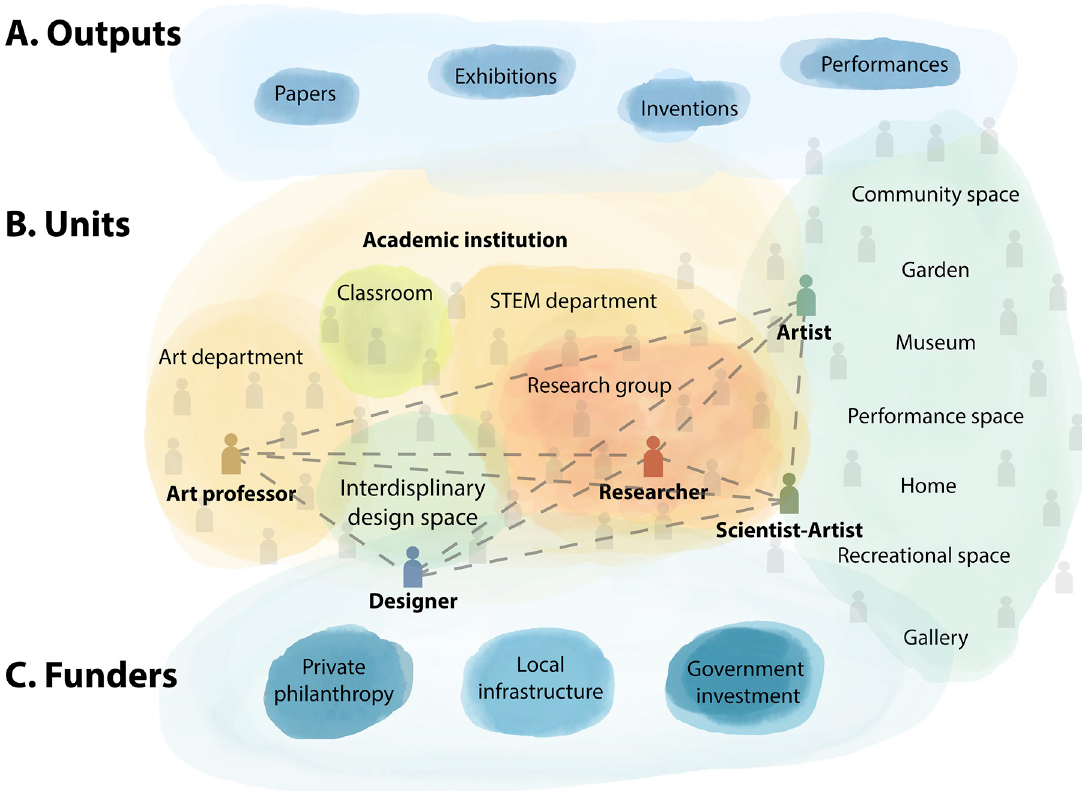
Fig 1. Integrating art and science. (A) Diverse outputs come from science–art collaborations, including papers, exhibitions, inventions, performances, and others. (B) These collaborations can be within academic institutions (such as STEM departments, art departments, in the classroom, or in transdisciplinary spaces such as maker spaces), and outside of academic institutions (such as in community spaces, gardens, museums, performance spaces, recreational spaces, galleries, or even at home). Individuals who move in each of these spaces can be connected, and some can span multiple spaces (in color). (C) Potential funding sources to support this work include private philanthropy, local infrastructure, and government